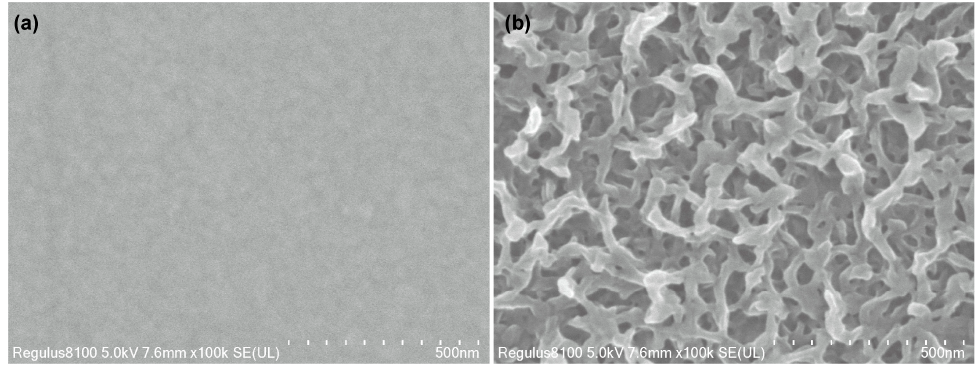
Figure 5. SEM images of ( a ) PEDOT:PSS film and ( b ) PEDOT:PSS/PEDOT (30 mC) film.